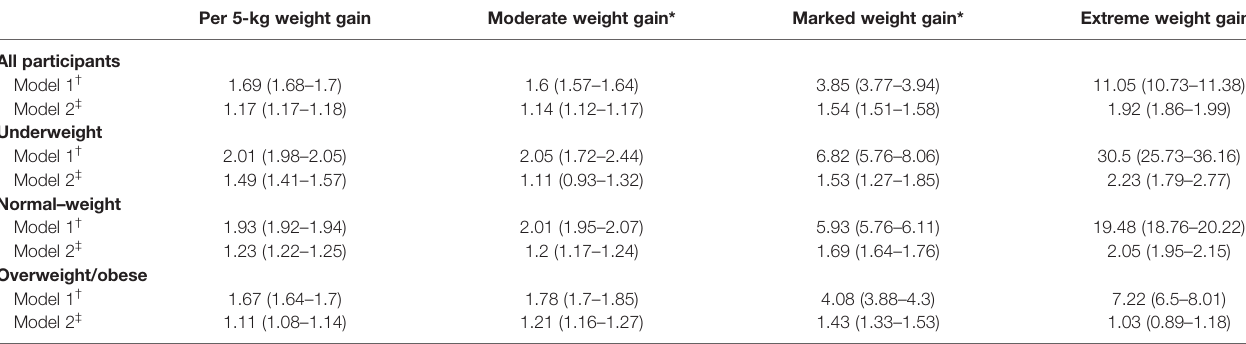
TABLE 2 | Odds ratios of metabolic syndrome associated with weight gain from young to middle adulthood by overall and BMI categories at young adulthood. Per 5-kg weight gain